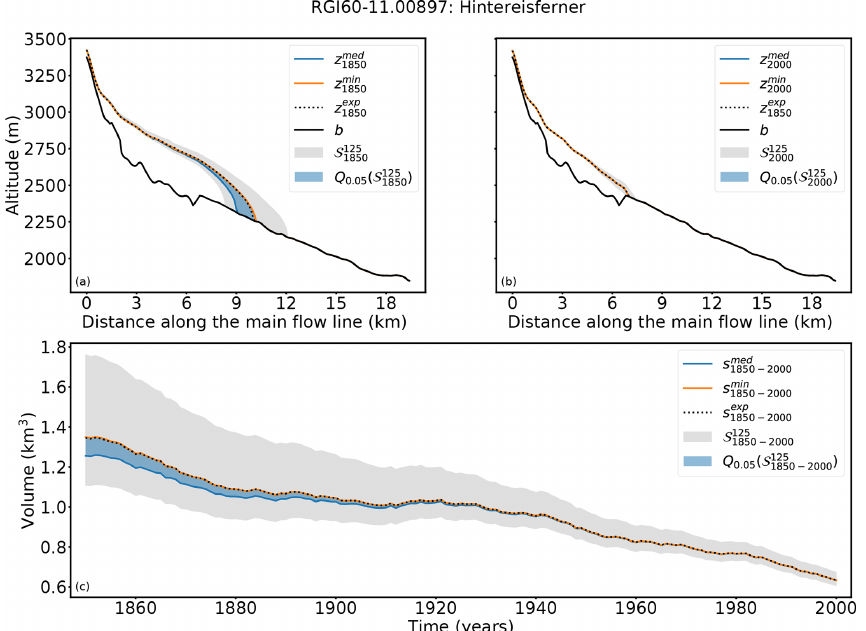
Figure 6. Results for Hintereisferner (Ötztal, Austria). Cross sections along the main flow line in (a) 1850 and (b) 2000 are shown. (c) Volume changes from 1850 to 2000. The grey shaded area indicates the range of all solutions with a fitness value smaller than 1 ( S 125 shaded area shows the range of the 5th quantile of S 125 t , the blue line s med t , and the orange line s min t .